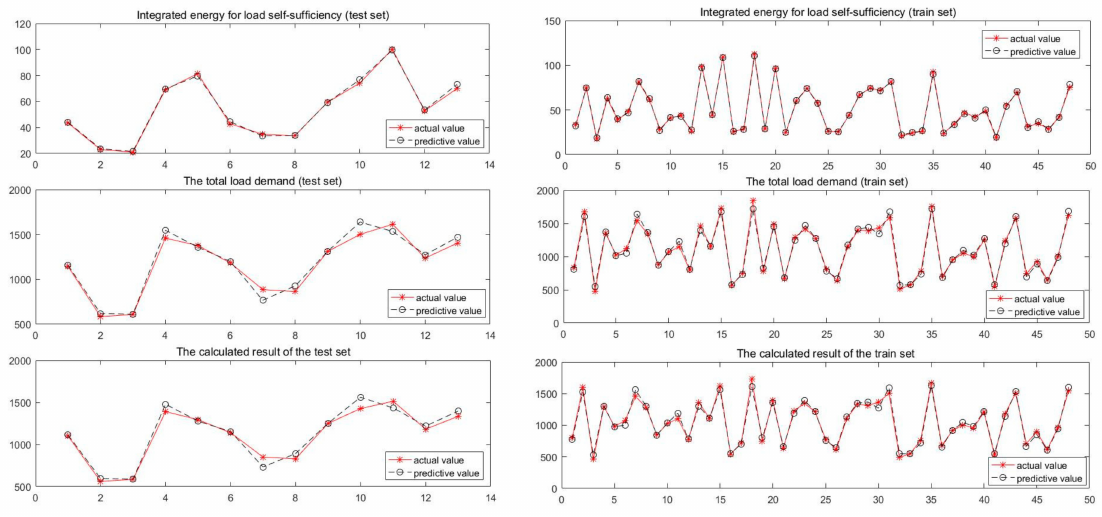
Figure 8. Model forecasting results.